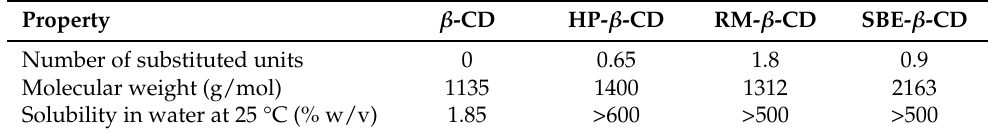
Table 2. Characteristics of some derivative β